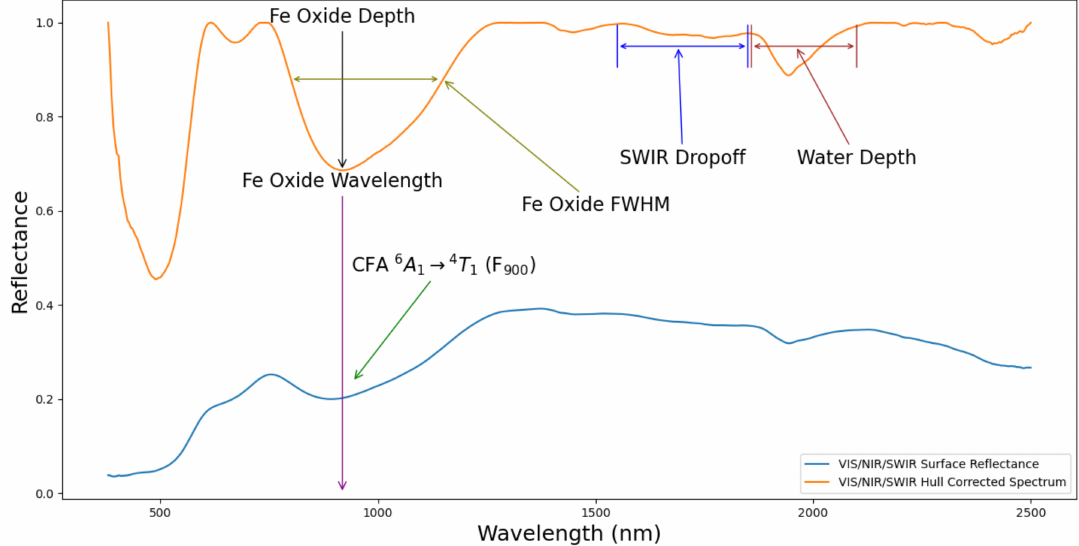
Figure 1. A surface reflectance goethite sample (blue spectrum) showing the 6 A 1 → 4 T 1 (F 900 ) crystal absorption feature at approximately 900 nm. The upper spectrum in orange is the hull-corrected spectrum. The hull-corrected F 900 feature is used to define the point at which the deepest absorption value occurs and defines the Fe oxide wavelength, Fe oxide FWHM and Fe oxide depth spectral metrics. The wavelength region between 1550 and 1850 nm is the region where a local hull correction is performed, and the maximum depth recorded as the SWIR dropoff metric. The region between 1850 and 2100 nm also uses a local correction to calculate the maximum depth and is recorded as the water depth. See Figure 2 for an example of the iron boomerang